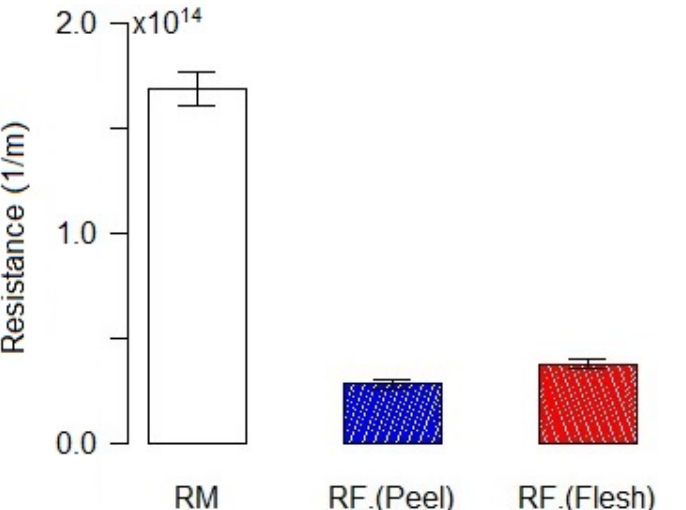
Figure 5. Membrane resistance (RM) and fouling resistance (RF) of RO membrane (X20).